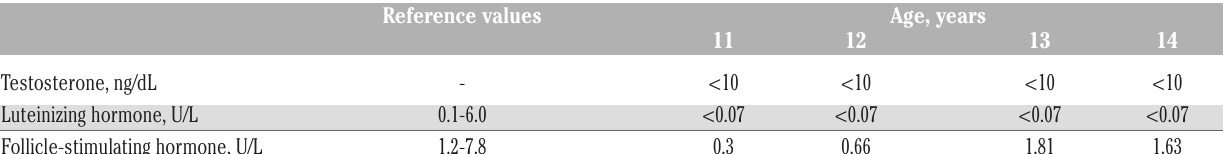
Table 2. Patient’s gonadotropins and testosterone measurements throughout preadolescence and adolescence, prior to testosterone replacement